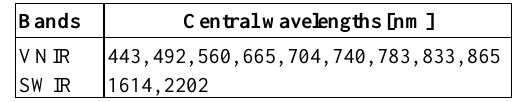
Table 1 . The central wavelengths of Sentinel-2A bands in VNIR and SWIR portions of the spectrum as outputs of the DSF atmospheric correction.